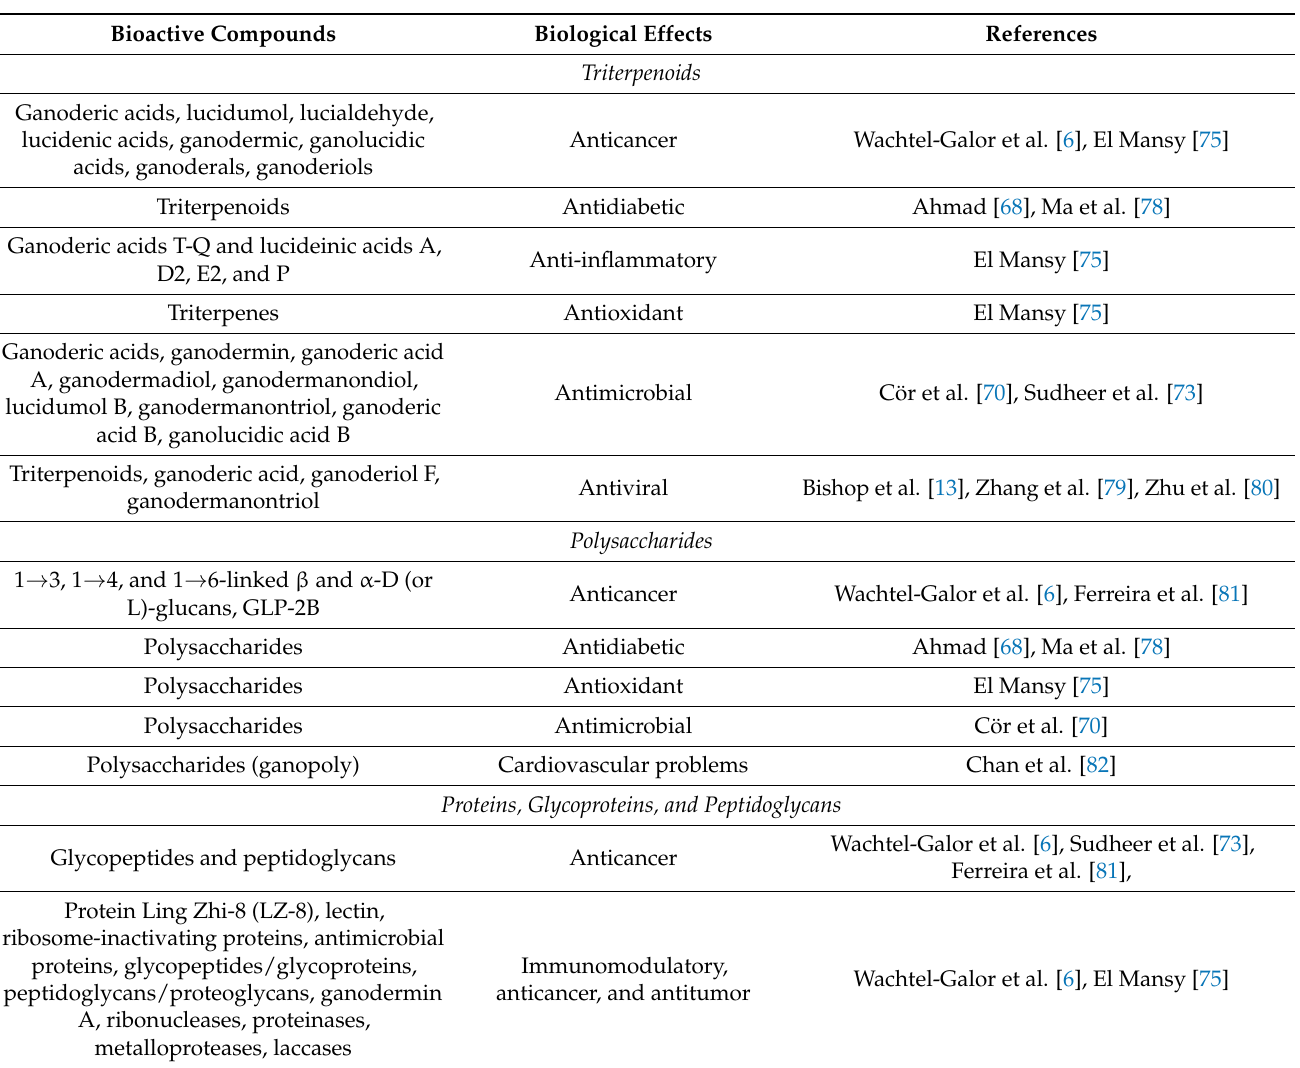
Table 3. The major bioactive compounds of G . lucidum and their biological